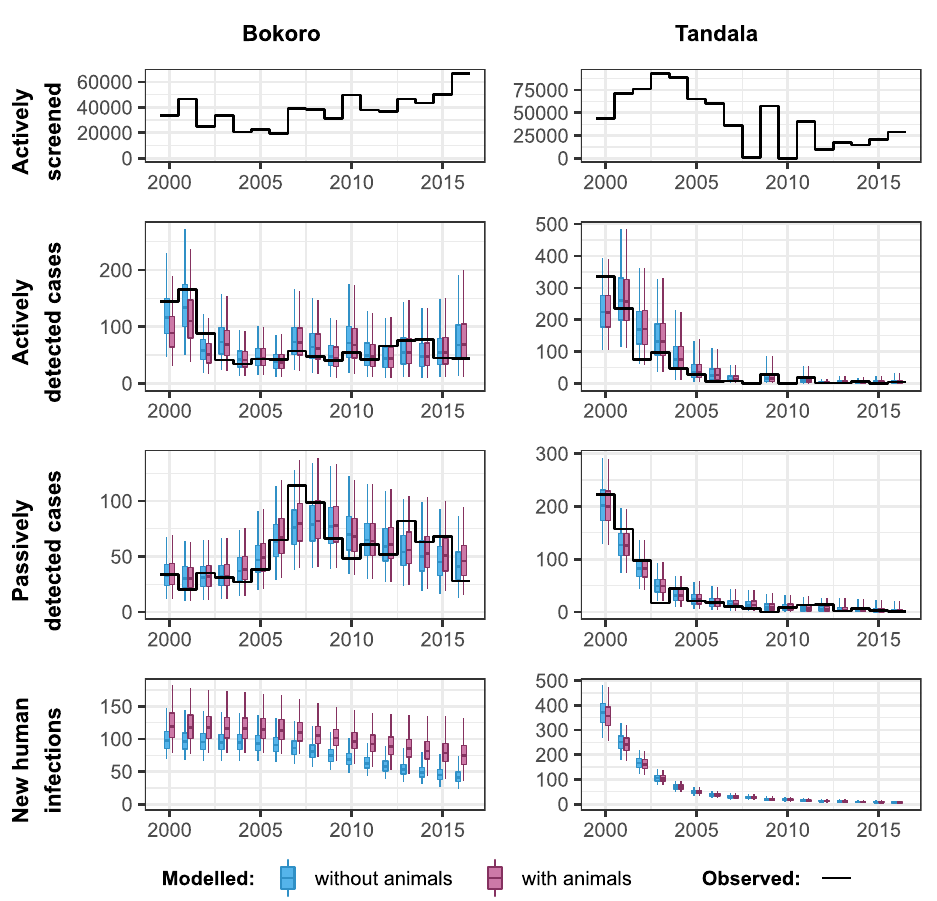
Fig 2. Fits to historical case data for Bokoro and Tandala health zones, for models with (in pink) and without (in blue) animals contributing to gHAT transmission. Reported data are shown as a solid black line and each boxplot shows the 2.5% and 97.5% quantiles of the model fit as the extreme point of the whiskers, 25% and 75% quantiles delimiting the box, and the median as the mid-line of the box.